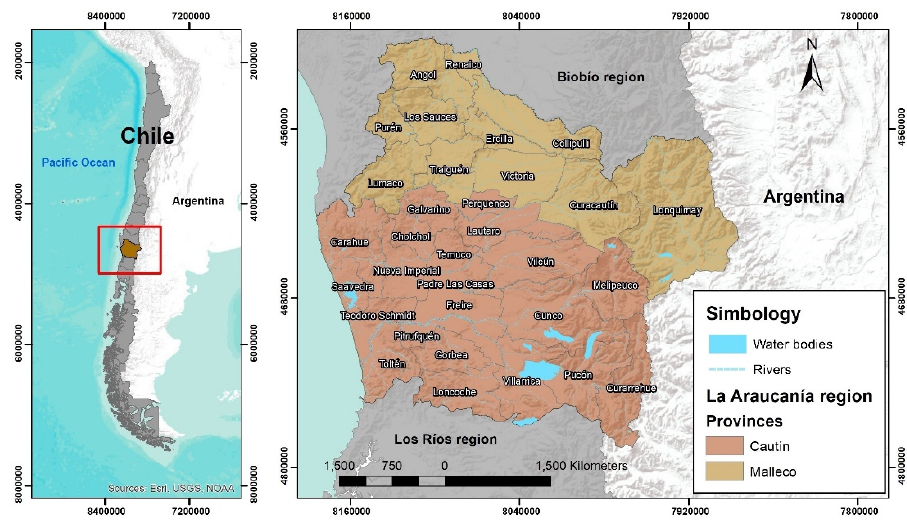
Figure 1. Study area: Araucanía region, Chile.